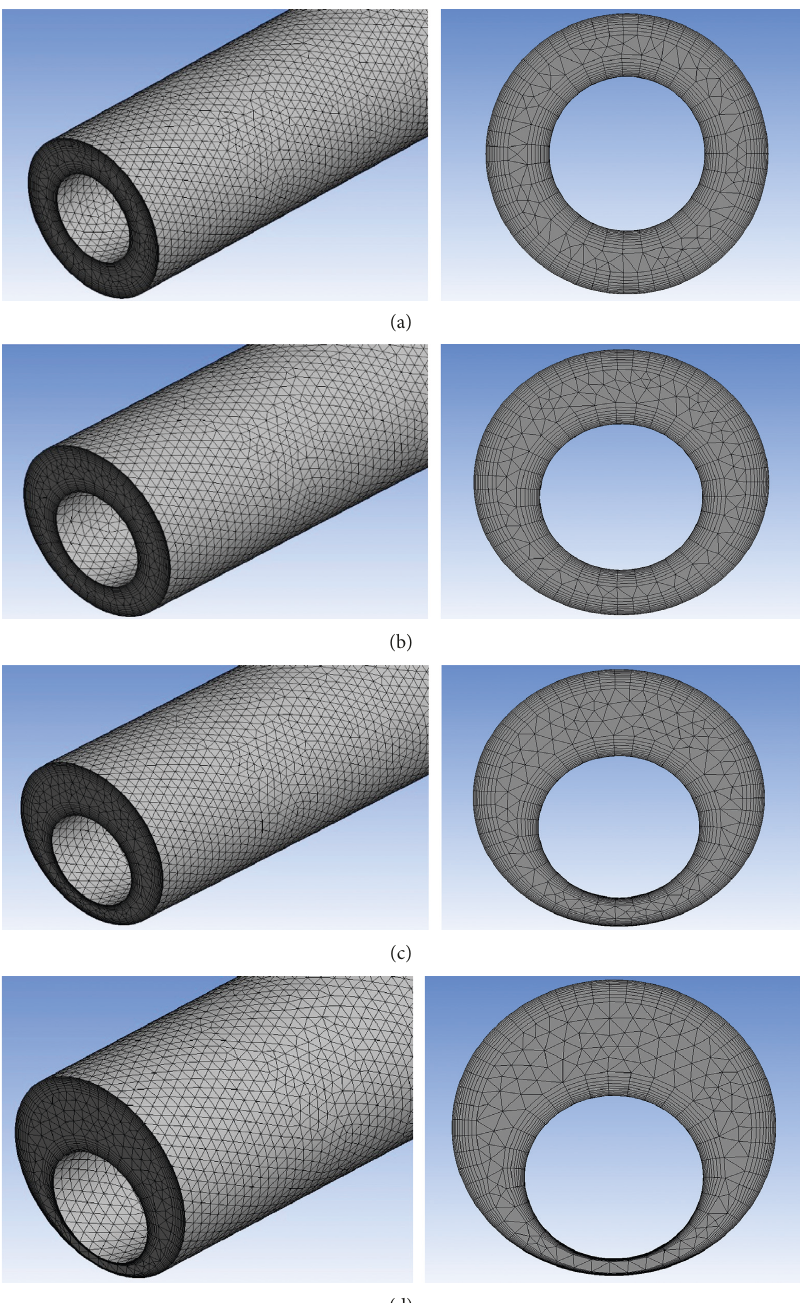
Figure 4: Mesh distribution. (a) Concentric inner pipe (number of nodes 901595). (b) 25% eccentric inner pipe (number of nodes 897540). (c) 50% eccentric inner pipe (number of nodes 909730). (d) 75% eccentric inner pipe (number of nodes